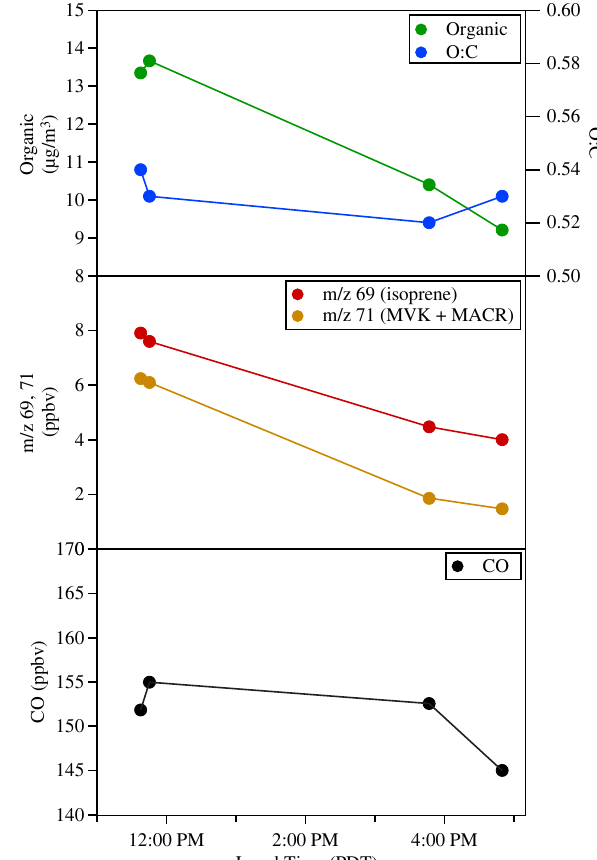
Fig. 7. Evolution of the average concentration of OA, CO, and bio- genic tracers on the 28 June flights for a region of the flight domain influenced predominantly by fresh biogenic emissions (labeled d and g in Figs. 3 and 4). Each point is the average of approximately 170 s of data representing a pass of the G-1 through the region. Lines are shown to guide the